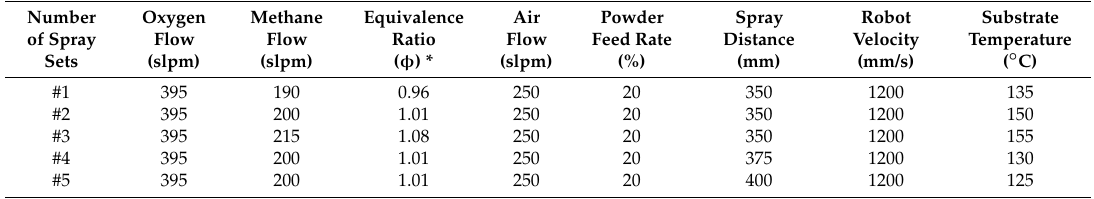
Table 3. APS spray parameters for Si deposition.